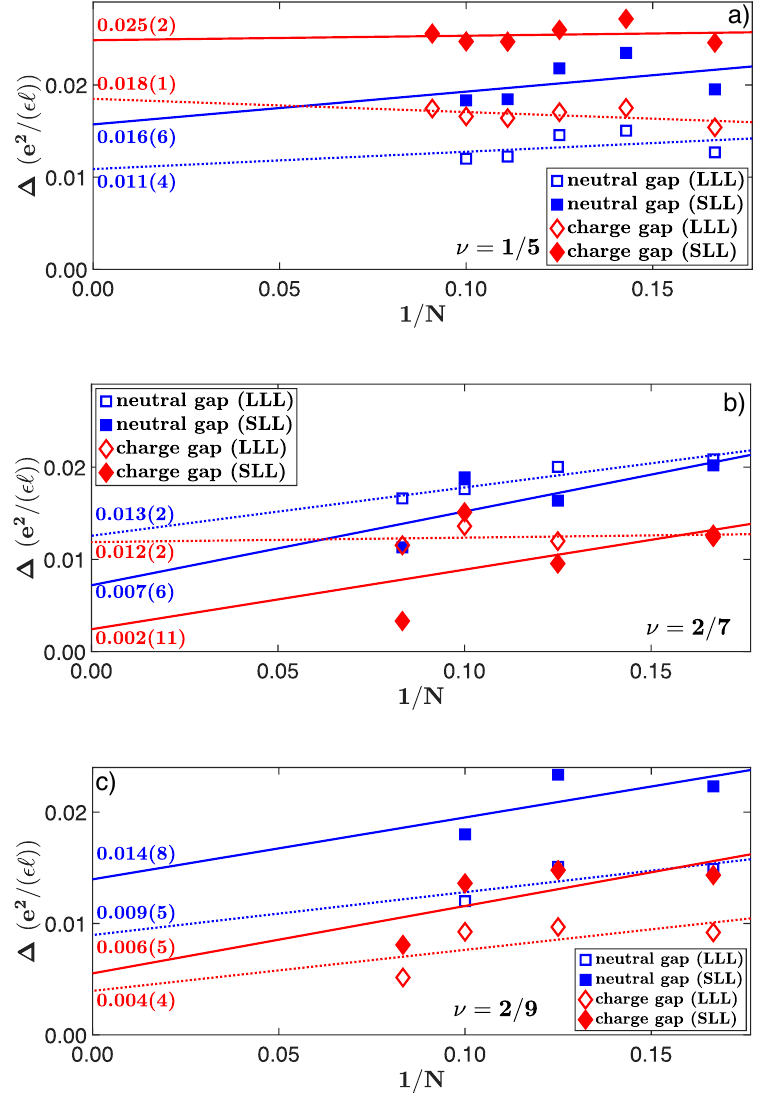
Figure 5: (color online) Thermodynamic extrapolations of the charge (red diamonds) and neutral (blue squares) gaps in the second Landau level (filled symbols) at ν = 1 / 5 (left panel), 2 / 7 (center panel) and 2 / 9 (right panel) obtained from exact diagonal- ization in the spherical geometry. The extrapolated gaps, obtained from a linear fit in 1 / N , are quoted in Coulomb units of e 2 / ( ε(cid:96) ) on the plot, with the error in the extrapolation shown in the parenthesis. For comparison we have also shown the corresponding lowest Landau level gaps (open symbols). The lowest Landau level charge gaps at 1 / 5 and 2 / 9 were previously given in Ref. [ 68 ]